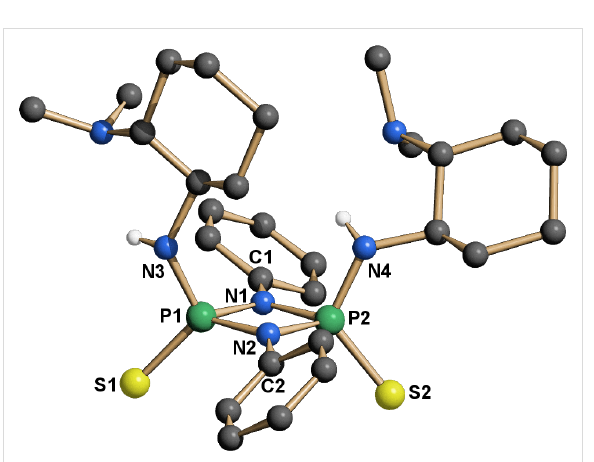
Figure 5: X-ray structure of 14a . The hydrogen atoms are omitted for clarity, except at nitrogen.